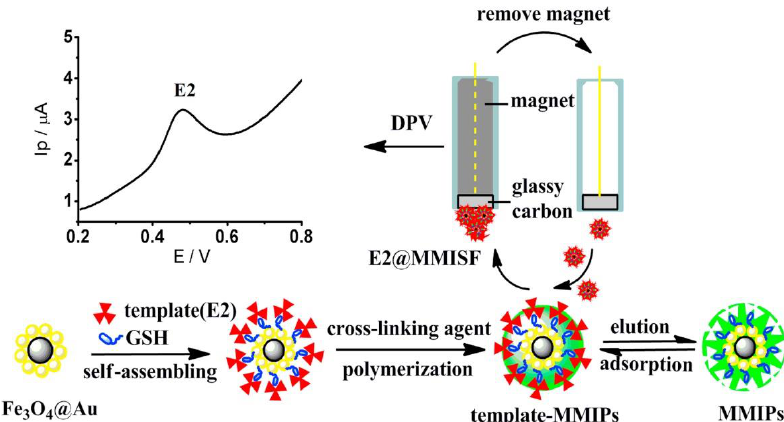
Figure 5. Scheme of a MIP@GSH-Au@Fe 3 O 4 @GCE preparation and differential pulse voltammetry (DPV) measurement performance for the analysis of estradiol in milk powder samples. Reproduced from [77], with permission from Elsevier, 2020.